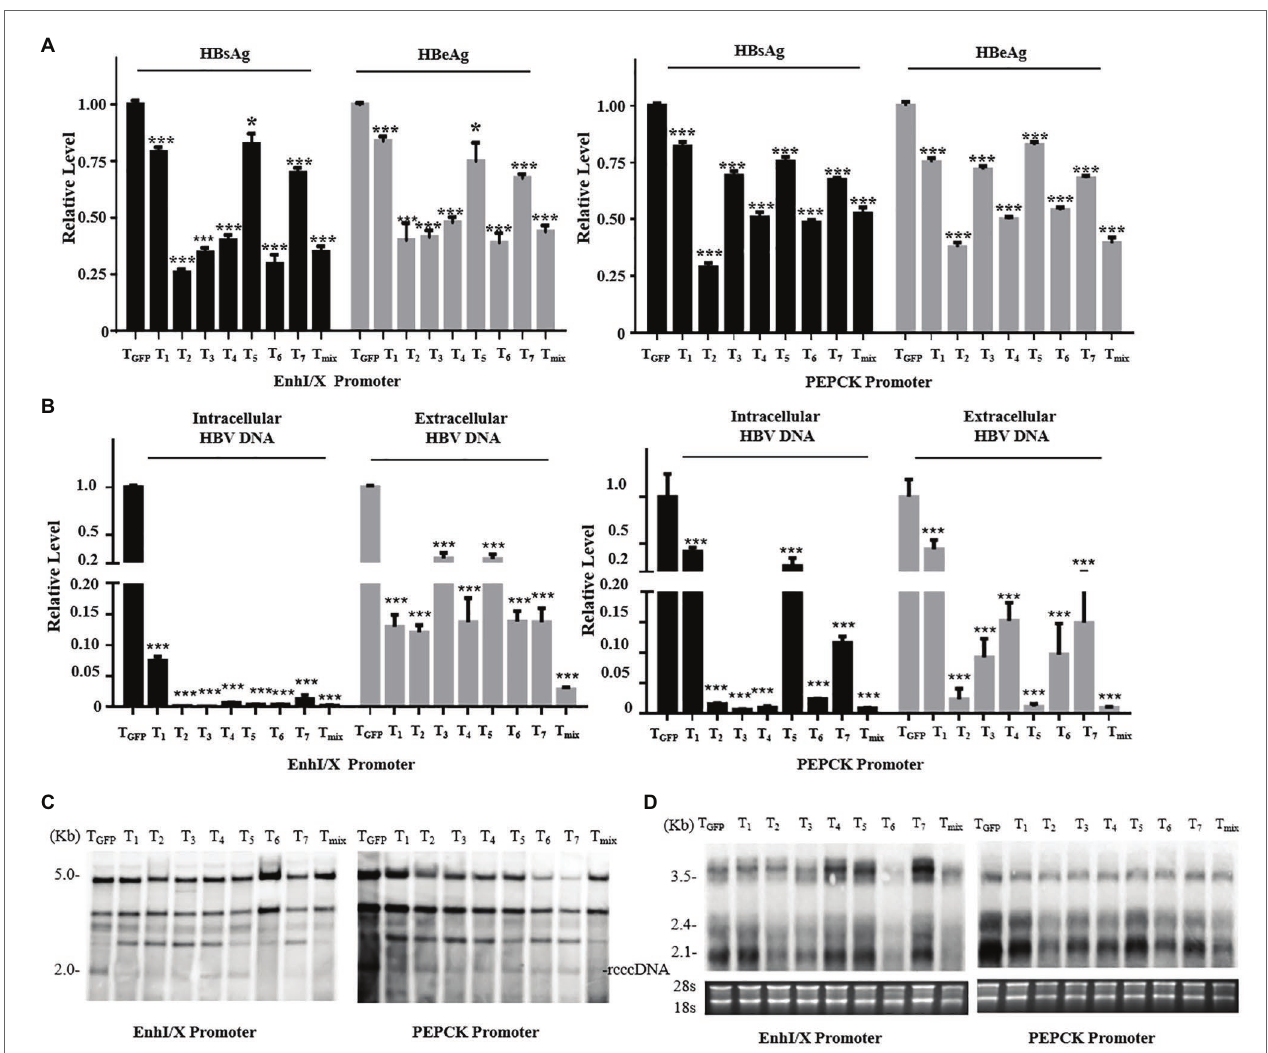
FIGURE 2 | Anti-HBV effects of the reconstructed CRISPR/SaCas9 system under the control of single liver-specific promoter in Huh7 cells. Huh7 cells were co- transfected with reconstructed gRNA/SaCas9 system plasmids and reproduce rcccDNA system plasmids. (A) At 48 h post-transfection, the relative levels of HBsAg and HBeAg were measured by ELISA. (B) At 96 h post-transfection, intracellular HBV replication intermediates and extracellular virion DNA were extracted and the expression levels were measured using quantitative PCR (qPCR). (C) The expression levels of HBV intracellular replication were measured by Southern blotting. (D) The expression levels of the HBV transcripts were measured by Northern blotting. In each of the transfections, the pSV- β -gal plasmid was included to normalize the transfection efficiencies. The results of the ELISA and qPCR were calculated from three independent experiments, and the data are presented as the mean ± SEM. * p < 0.05 and *** p < 0.001. T mix , the mixture of T 1 –T 7